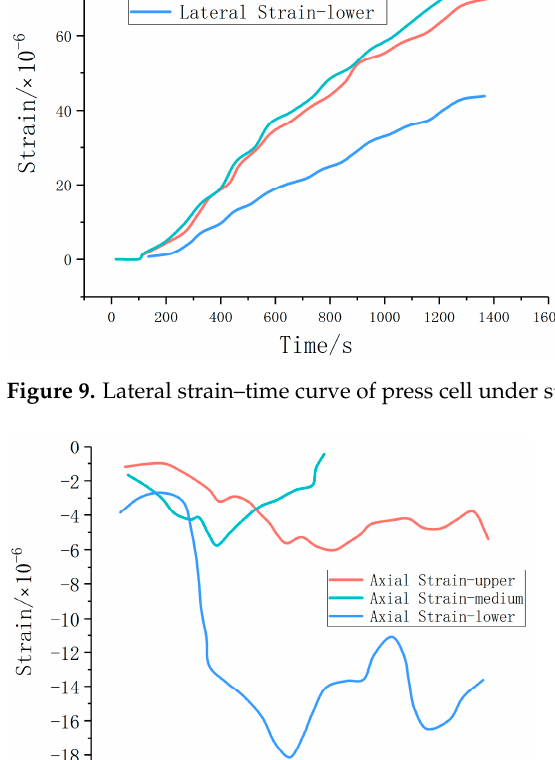
Figure 10. Axial strain–time curve of press cell under stress.